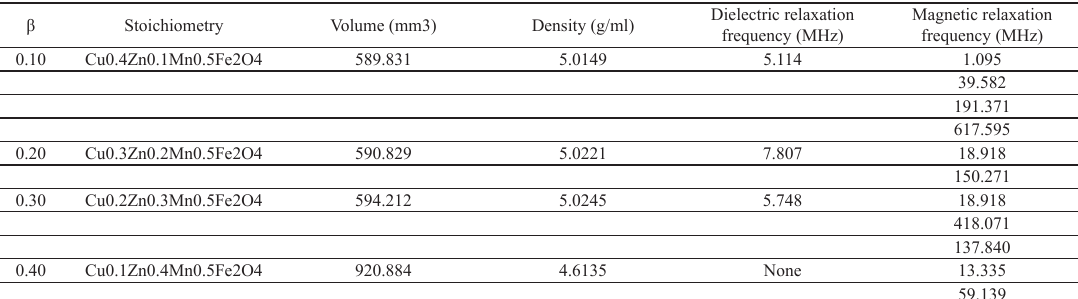
Table 8. Summary of samples characteristics. β